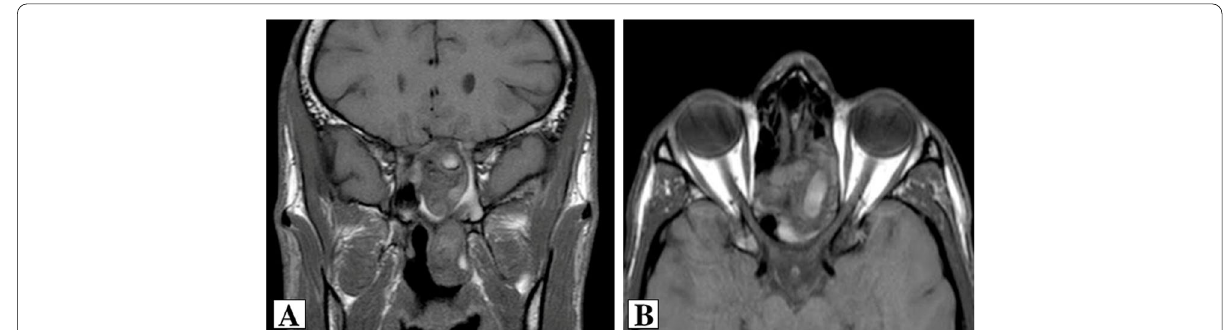
Fig. 1 T1- weighted post-contrast MRI showing the lesion of interest. A Coronal image showing a multiloculated, isointense to hyperintense lesion in the nasopharynx and sphenoid sinus causing slight indentation and erosion of sphenoid skull base. B Axial image shows the lesion involving bilateral ethmoid sinus and causing slight indentation over left optic